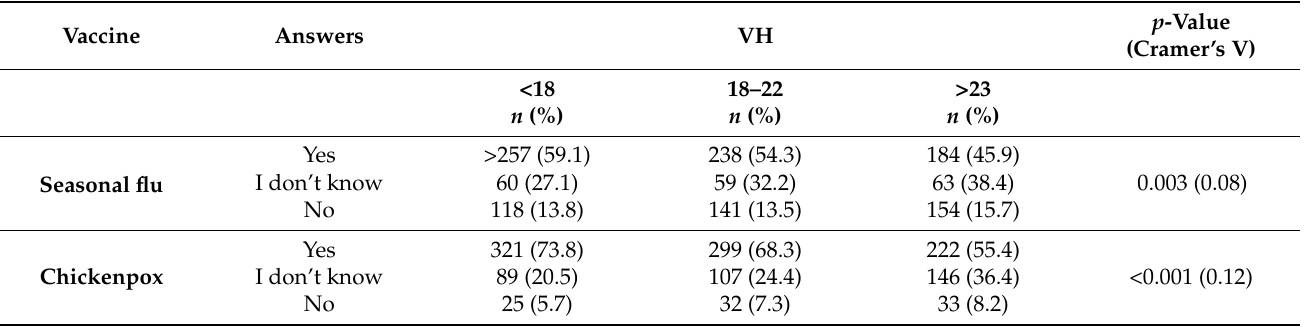
Table 2. Do you know which of the following vaccinations are recommended for healthcare profes-